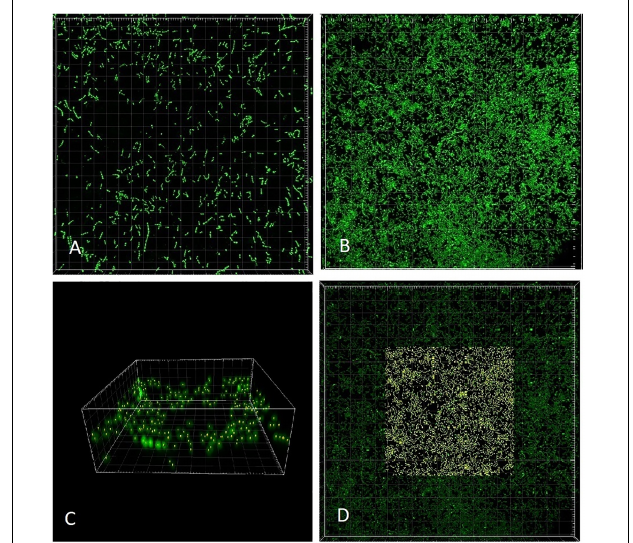
FIGURE 3 | CLSM (Syto 9) 3-dimensional rendering of Enterococcus faecalis biofilms at two different dilution rates ( D ). (A) D = 0.09 h − 1 and (B–D) D = 0.81 h − 1 . Cells marked with Imaris Point Viewer (C) entire image and (D) central 25% of image volume (same CLSM file as B ). Side of the square base of image (A , B , D) 203.2 µ m and side of the square base of image (C) 25.4 µ